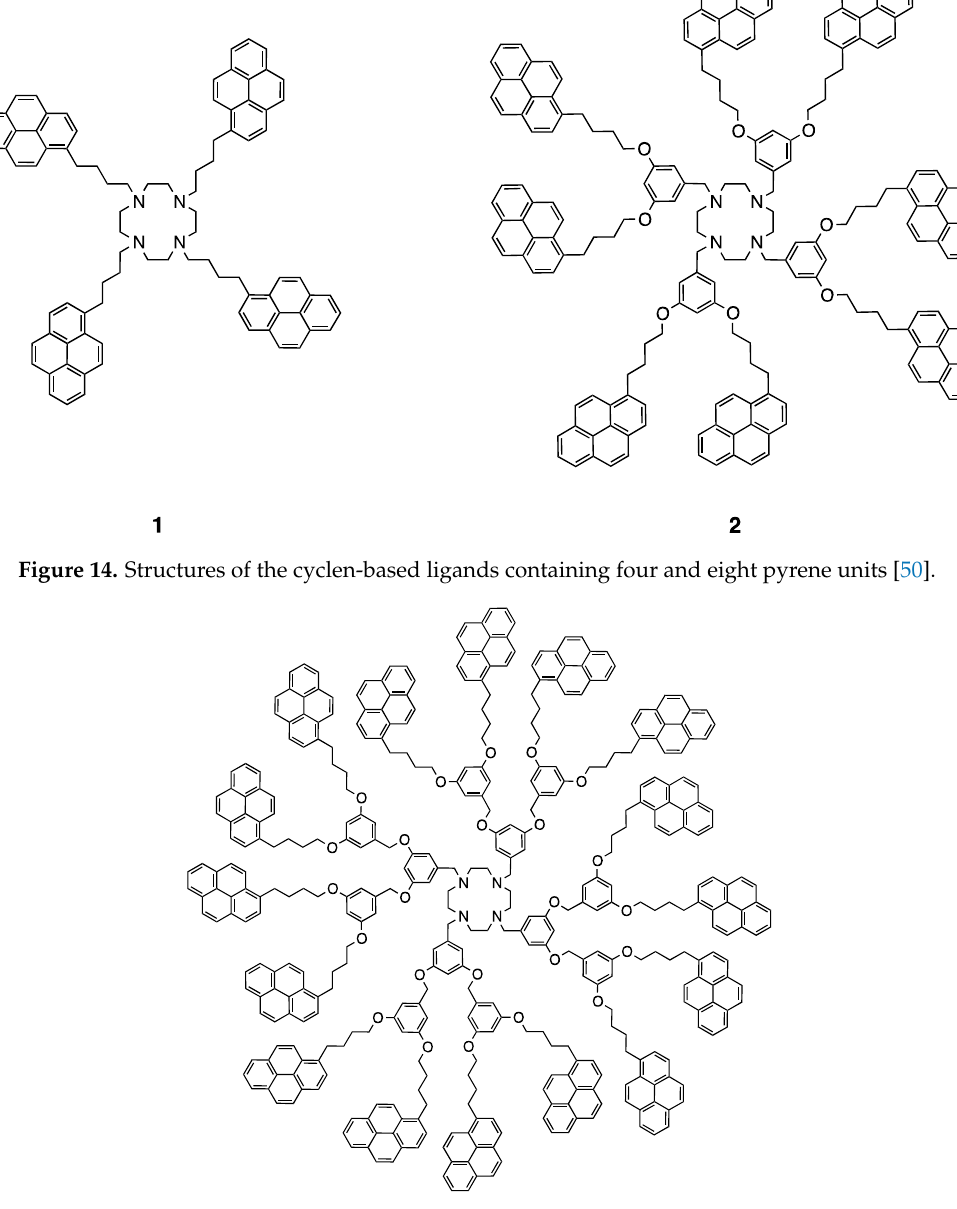
Figure 15. Structures of the cyclen-based ligand containing 16 pyrene units [50].